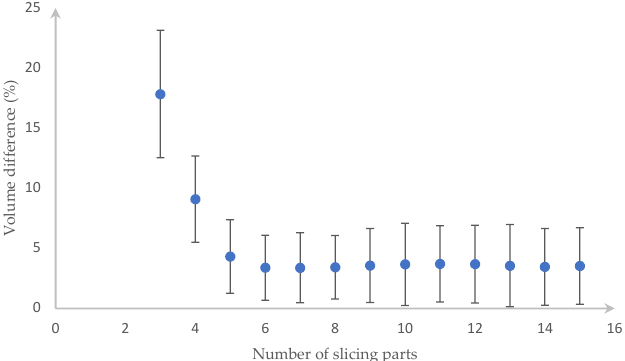
Figure 15. Percentage errors when slicing the carrot into 3 to 15 parts.